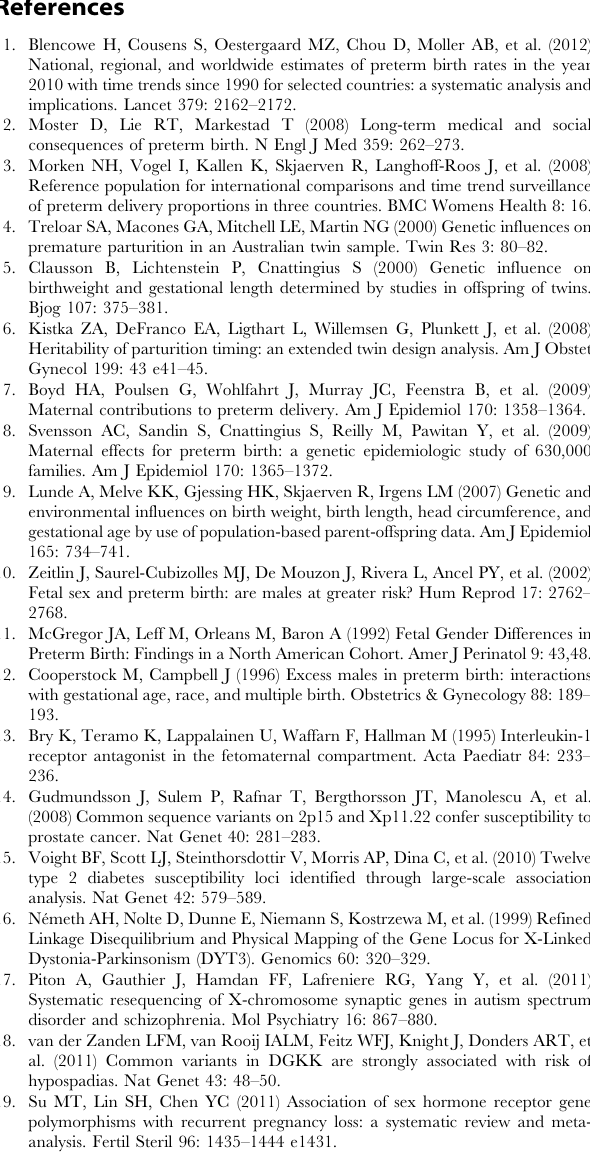
Table S1 Maternal results for SNPs with p , 1.00 6 10 2 3 . Table S2 Fetal results for SNPs with p , 1.00 6 10 2 3 . Table S3 Sex-stratified analysis, males, p , 1.00 6 10 2 3 .